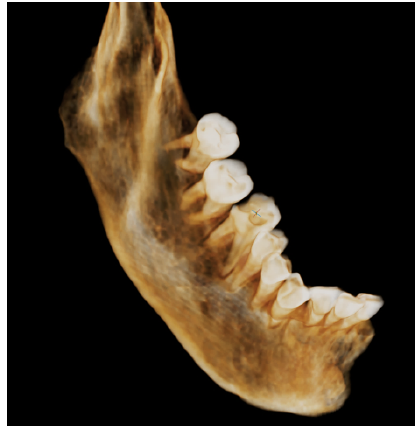
Figure 3. Mandible fragment CBCT scan (Early Bronze) Tooth segmentation was performed by Ravil M. Galeev (Insti- tute of Ethnology and Anthropology of Russian Academy of Sci- ences) on mandible fragment (Early Bronze Age). Segmenta- tion performed on Inobitec DICOM (Russian Federation) soft- ware allowed to extract image of molar (4.7) from the scan. As the mandible fragment had been previously scanned by intrao- images of the tooth, but its coronal part. Preliminary image com- bining was performed for accuracy assessment, but not continued due to obvious results showing discrepancy (Figure 4). Intraoral scanner should be used for surface scanning rather than